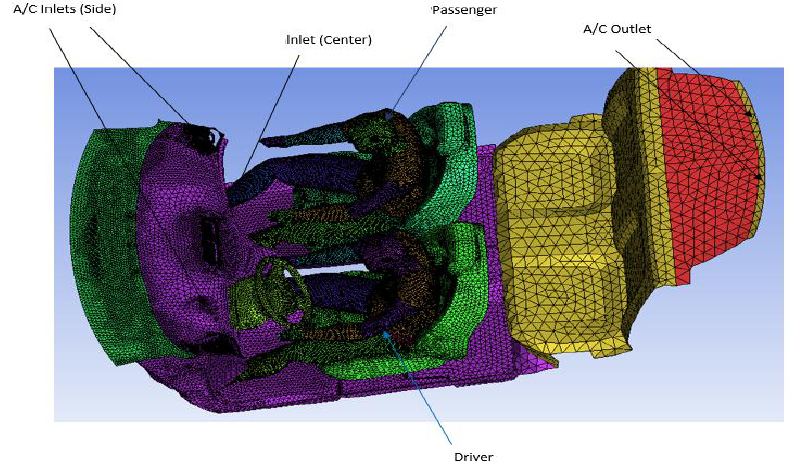
Figure 2. Computational grid for the numerical calculations with the segmented human manikin.